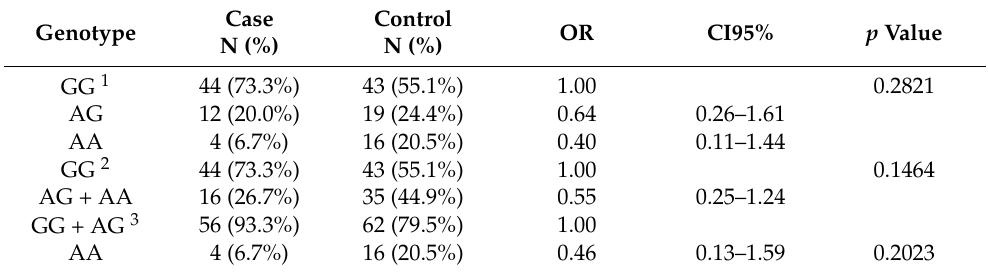
Table 2. Association of the rs820218 variant of the SAP30BP gene with the case and control groups. Genotype